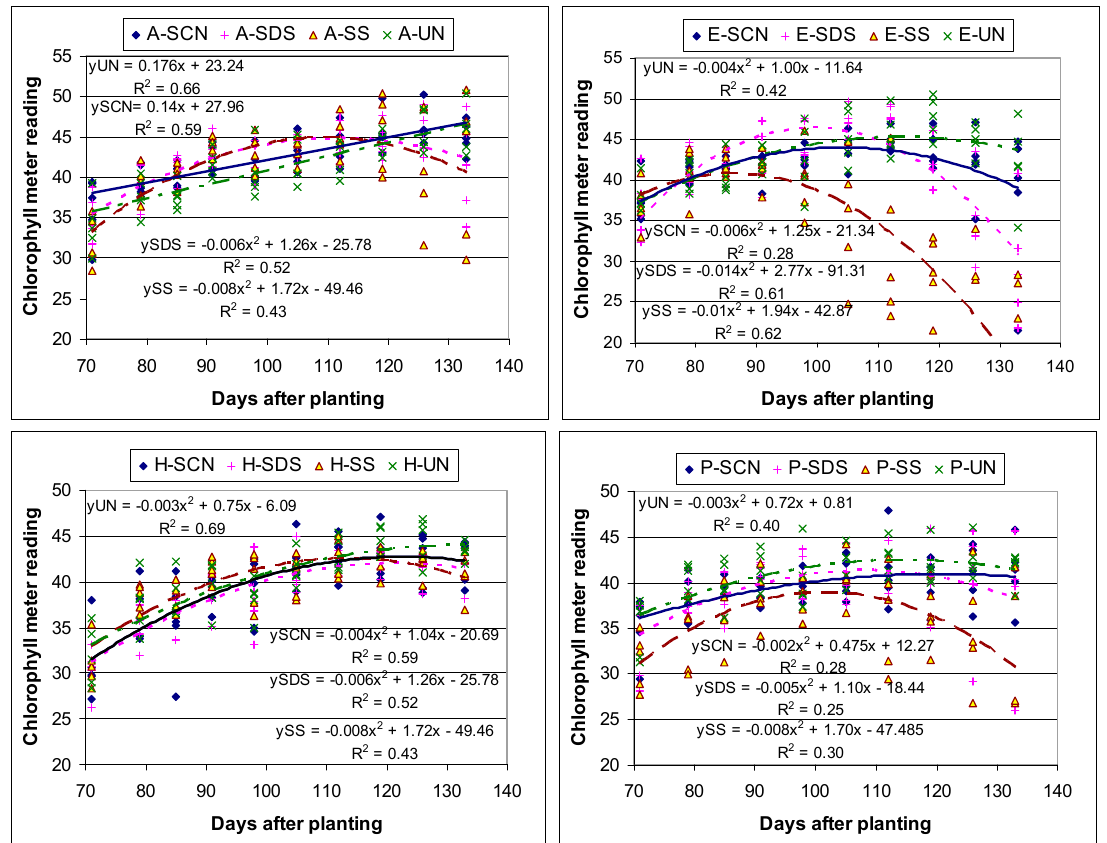
Figure 2. Change in chlorophyll content, measured with a chlorophyll meter, plotted against time in four soybean cultivars under four disease treatments, namely, Control (UN), soybean cyst nematode (SCN), sudden death syndrome (SDS), and SCN + SDS (SS). The four cultivars were Asgrow 5603 (A-SDS susceptible), Essex (E-SDS & SCN susceptible), Hartwig (H-SDS & SCN resistant) and Pioneer (P-SCN susceptible).